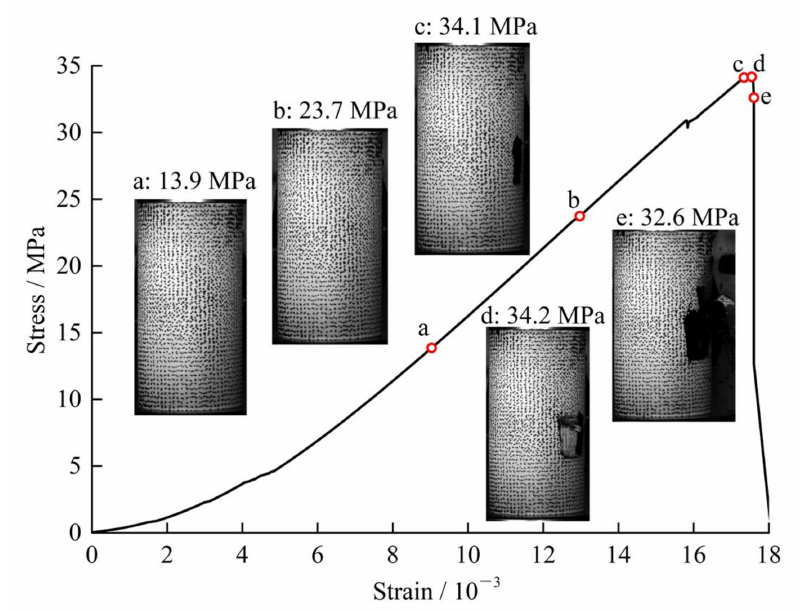
Figure 6. The stress-strain curve and key loading points of specimen